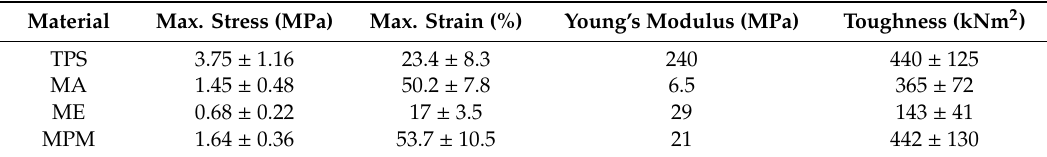
Figure 9. Micrographs of the edges of fractured MA, MPM and ME films after tensile tests. Table 2. Tensile tests results for pure TPS and its blended films with nopal mucilage (type MA, MPM and ME).